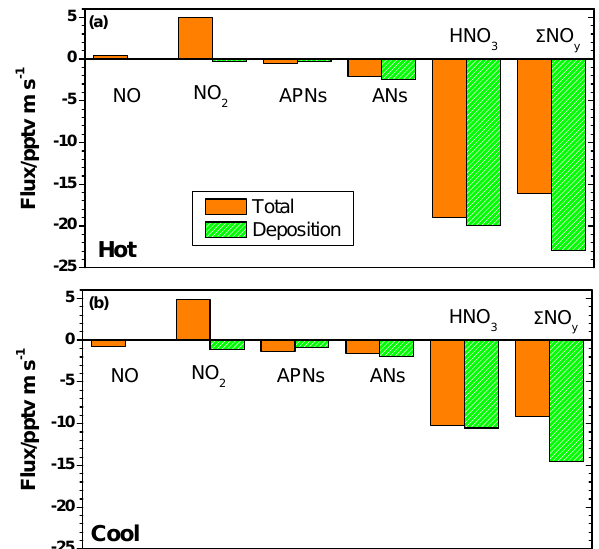
Fig. 12. Contributions of NO y components to dry depositional (green striped bars) and net (orange solid bars) fluxes as modeled at 20 m ( z/h = 2) for the (a) hot and (b) cool periods. To convert frompptvms − 1 tongNm − 2 s − 1 , multiply by